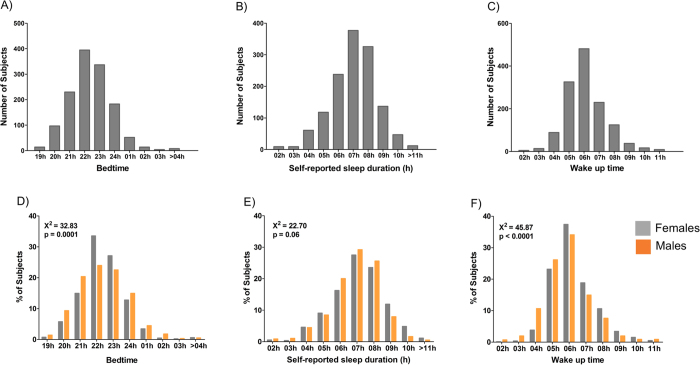
Frequency distribution histograms for self-reported sleep patterns derived from the PSQI (1,334 subjects were included).The upper panel shows the entire population, and the lower panel the same dataset divided by sex. (A and D) show bedtime frequency distribution binned by 1-hour intervals from 19 h to after 04 h. (B and E) show sleep duration frequency distribution binned by 1-hour intervals from 02 h to >11 h of sleep duration. (C and E) show wake-up time frequency distribution binned by 1-hour intervals from 01 h to 11 h. There was higher proportion of male subjects going to bed before 23 h χ2 = 32.83; p < 0.0001 (D), and a higher proportion of male subjects presenting earlier wake up times Χ2 = 45.87; p < 0.001 (F).